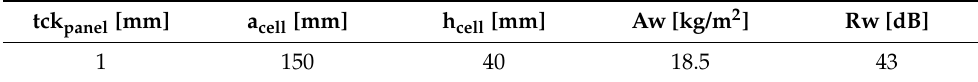
Table 3. Unit cell geometrical dimensions.